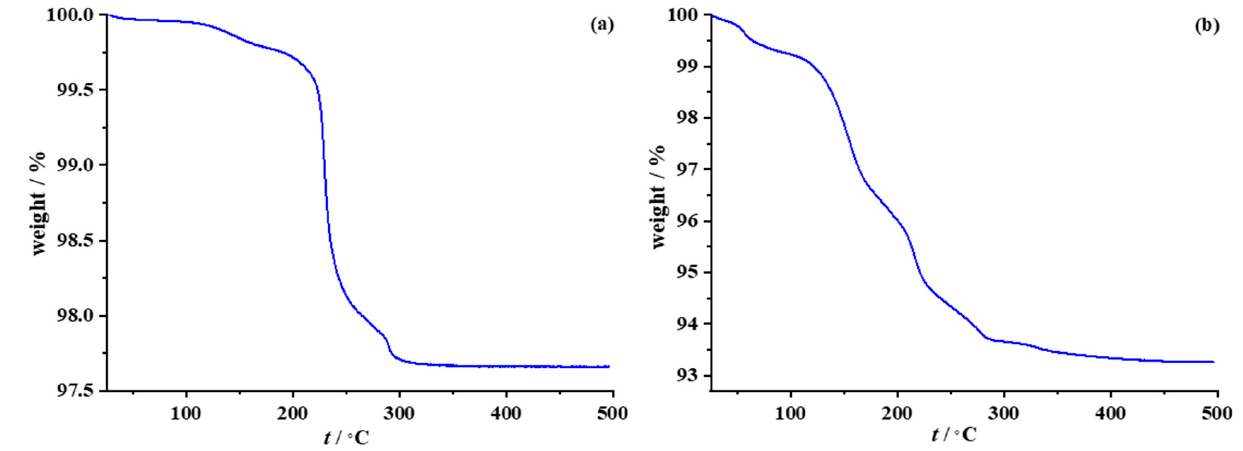
Figure 4. Thermal behavior of ( a ) PAA-AgNP and ( b )